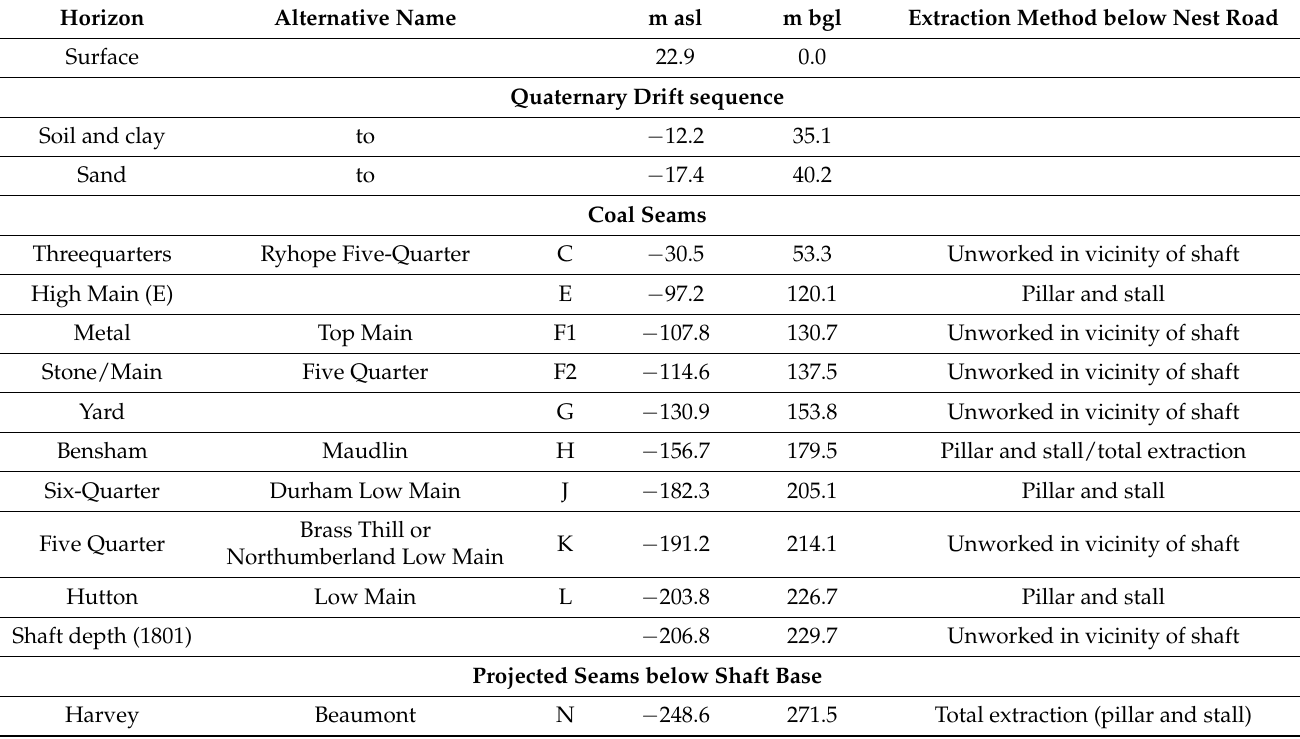
Table 2. The main features of strata encountered in the Venture Pit shaft (and projected down to Harvey-Beaumont ‘N’ seam), within the Nest Road site, using data from BGS record NZ26SE83 and [22]. Quaternary superficial material was 40.2 m thick in the shaft. The High Main Post